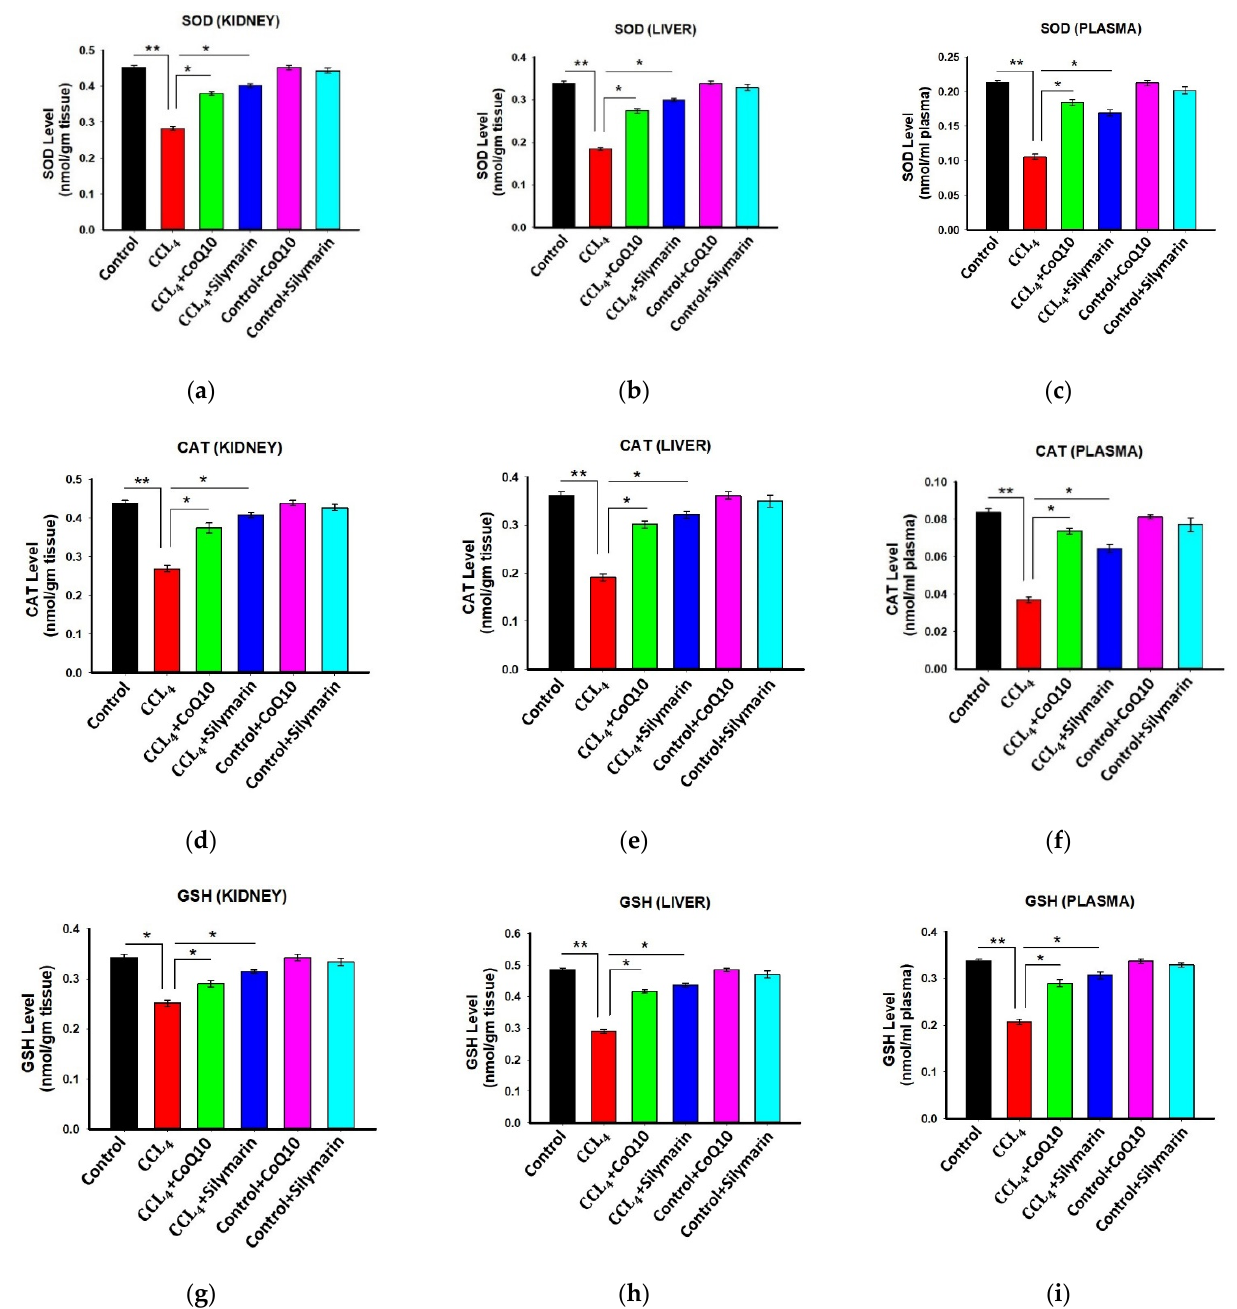
Figure 3. Effect of CoQ10 and silymarin on superoxide dismutase (SOD) ( a – c ), catalase ( d – f ), and reduced glutathione (GSH) ( g – i ) levels in kidney, liver, and plasma of ovariectomized female rats. Data are presented as mean ± SD (n = 6). Statistical analysis involved post-hoc tests. Statistical significance is indicated as * p ≤ 0.05 and ** p ≤